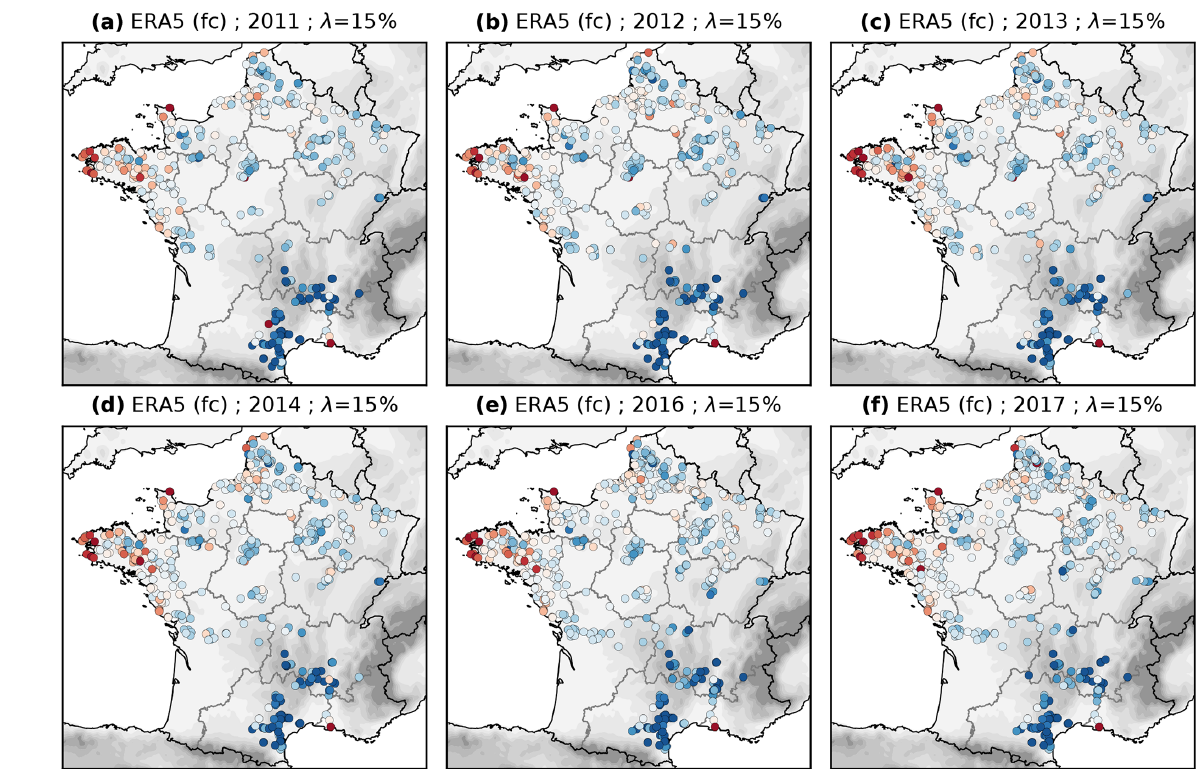
Figure 7. Local biases of wind-power production simulations based on ERA5 (forecasts) for years 2011 to 2017, except 2015 shown in Fig. 5b. Same scale as Fig.